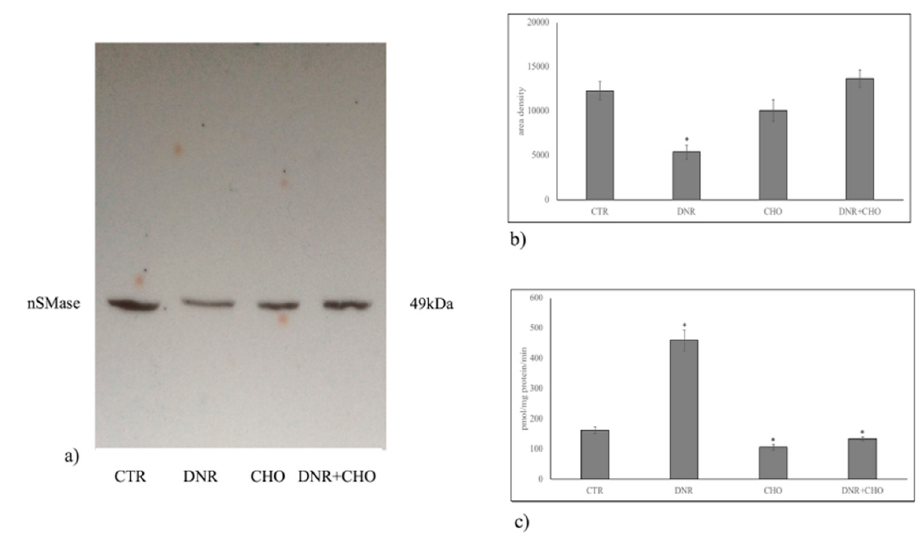
Figure 4. Effect of DNR, CHO, DNR–CHO on nSMase protein expression and activity in nuclear lipid microdomains purified from hepatoma cells. Cells were treated with 1 μ M DNR or 800 nM CHO or 1 μ M DNR + 800 nM CHO. ( a ) Immunoblotting. The position of the 49 kDa for nSMase was evaluated in relation to the position of molecular size standards; ( b ) the area density was quantified by densitometry scanning and analysis with Scion Image; ( c ) enzyme activity, data are expressed as pmol/mg protein/min. Results for b and c represent the mean ± SD of three independent experiments. * p < 0.05.